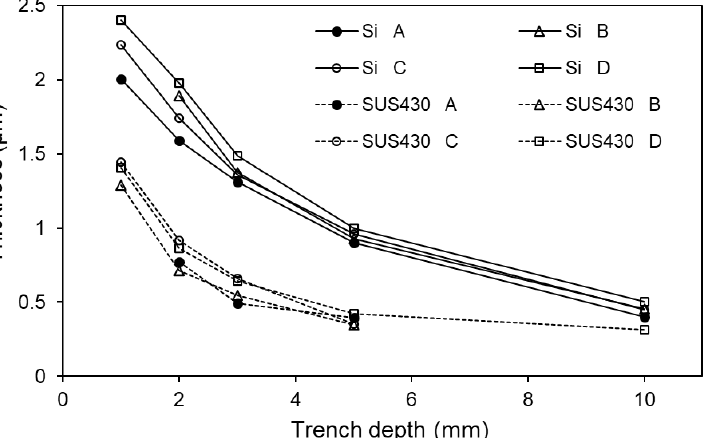
Figure 5. The thickness of a-C:H films deposited on the Si and stainless steel plates with different pretreatments.